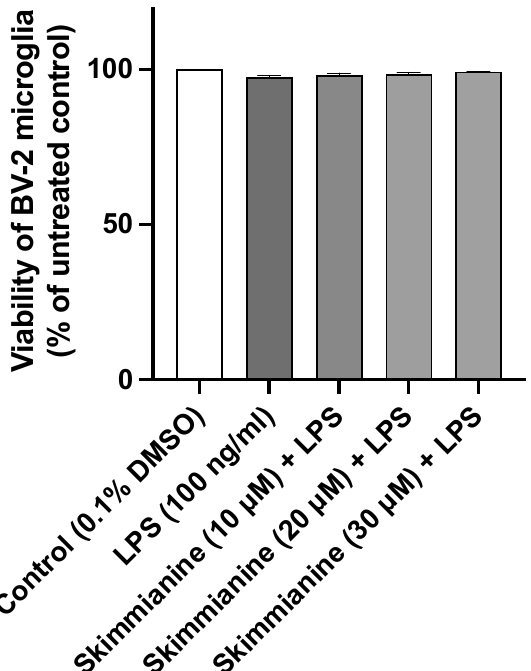
Figure 2. Skimmianine did not decrease the viability of BV-2 microglia cells. Pre-treatment with skimmianine (10, 20 and 30 µ M) did not reduce the viability of BV-2 cells when stimulated with LPS (100 ng/mL) for 24 h. An MTT assay was used to determine the viability of BV-2 cells after treatment. All values are expressed as mean ± SEM for three independent experiments. A statistical analysis was performed using one-way ANOVA with a post hoc Dunnett’s test.